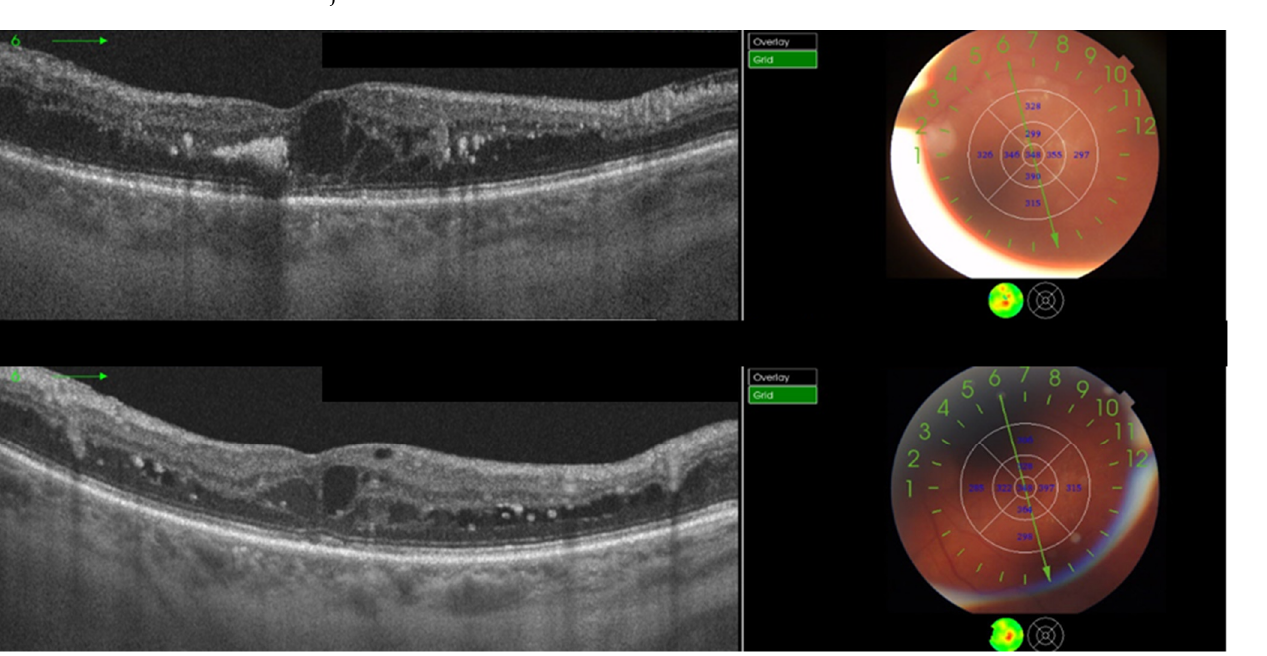
Figure 1. A patient with diabetic macular edema, showing optical coherence tomography at baseline (top) and 3 months after subthreshold micropulse laser treatment (bottom). Treatment consisted of 510 confluent panmacular applications using a 200 μ m retinal spot, 200 ms pulse duration, 400 mW power, and 5% duty cycle. The central retinal thickness was equal (348 μ m) at baseline and at 3 months and the mean retinal thickness decreased.